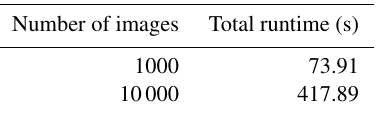
Table 4. Runtimes for the digit detection algorithm using a mid- 2014 MacBook Pro